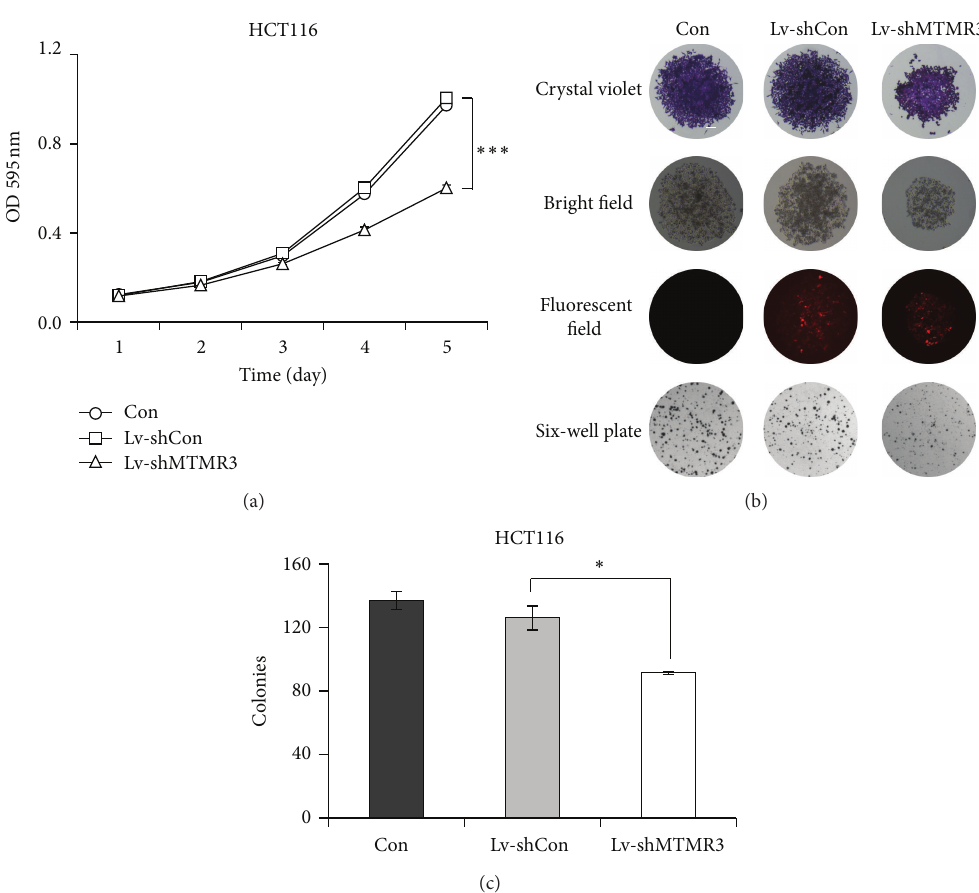
Figure 2: Lentivirus-mediated knockdown of MTMR3 suppresses the proliferation and the colony formation ability of HCT116 cells. (a) Growth curve of HCT116 cells with three treatments (Lv-shMTMR3, Lv-shCon, and Con) measured by the MTT assay. The experiment was performed in triplicate and repeated three times. (b) Representative images of colonies formed in HCT116 cells with three treatments (Lv- shMTMR3, Lv-shCon, and Con) examined by the colony formation assay (scale bar: 125 𝜇 m). The experiment was repeated three times. (c) Statistic results of the colony formation ability as shown ( ∗ 𝑃 < 0.05 , ∗∗∗ 𝑃 < 0.001